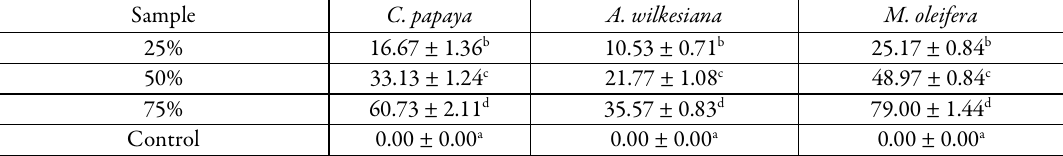
Values followed by the same superscript letter on the same column are not significantly different at p > 0.05 Values are presented in mean ± standard error of three